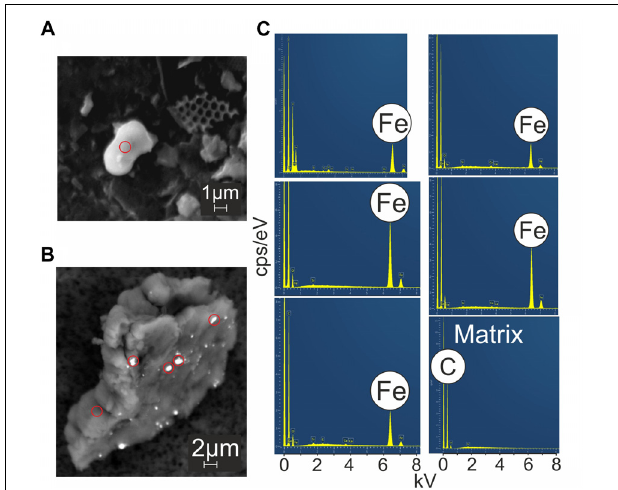
FIGURE 4 | Backscatter SEM images of VDVF plume particles (A,B) . Red circles correspond to points of EDX analysis (C) which show that brighter regions in the images were enriched in Fe.